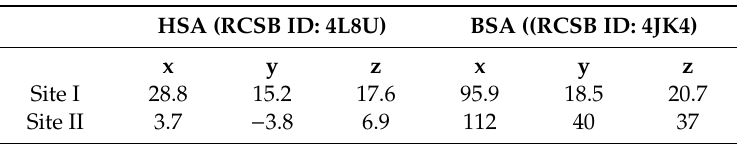
Figure 1. The binding sites I ( a , c ) and II ( b , d ) of human (HSA; ( a , b )) and bovine (BSA; ( c , d )) serum albumin macromolecule. Table 1. Coordinates of the binding sites in human (HSA) and bovine (BSA) serum albumin structures used for the docking calculations, and their RCSB IDs.